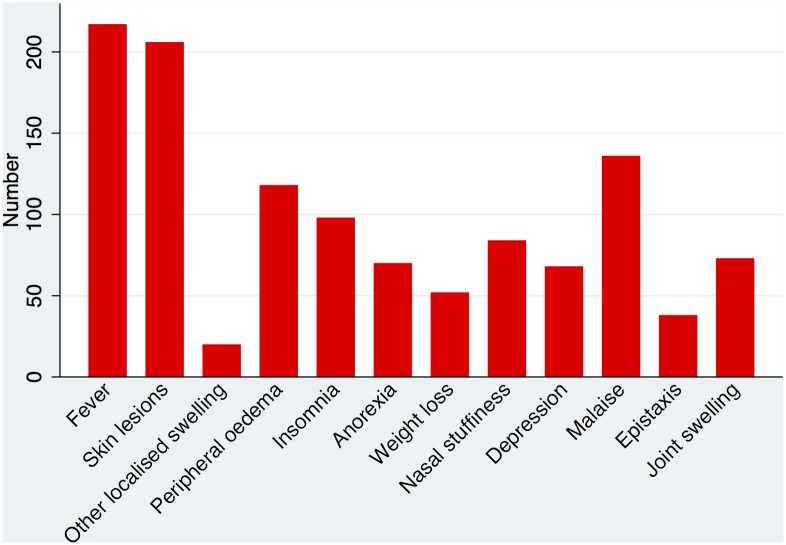
Symptoms other than pain in ENL.